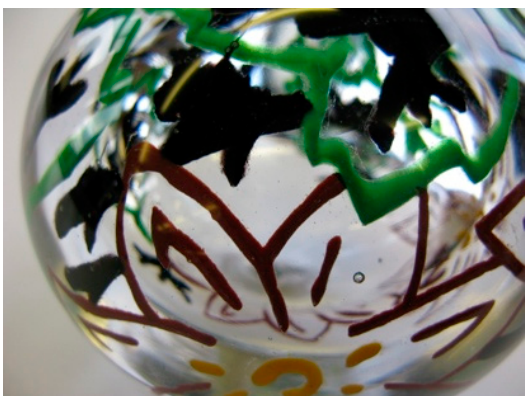
Figure 14. Drawing test (2011). Cristalica glass body with Kugler glass powder (opaque green (K2070-Opal green), opaque yellow (K2078-Canary yellow), opaque red (K2124-Poppy red) and opaque black (K2095-Opal black), 118 mm (H) × 85 mm (W).